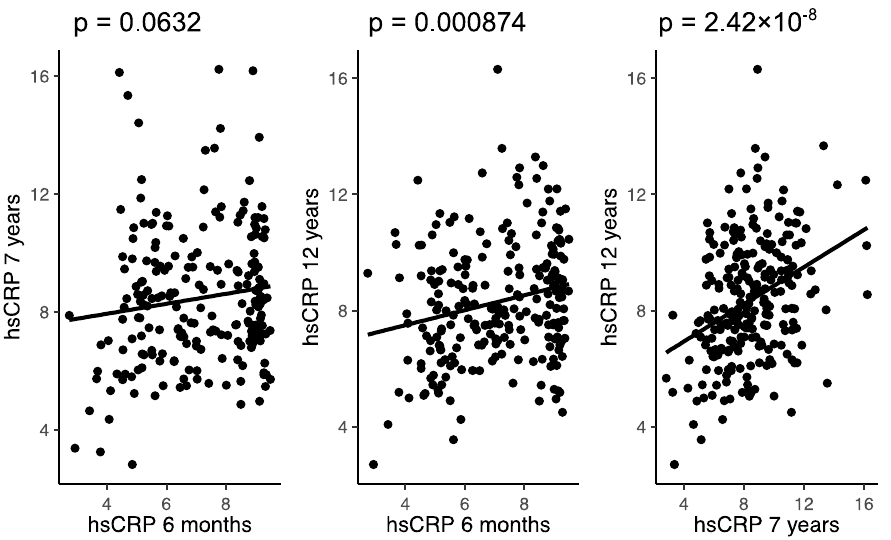
Figure 2. The associations between hs-CRP at age 6 months, 7 and 12 years in childhood in the COPSAC 2000 cohort. All values are in ng/mL and log transformed.